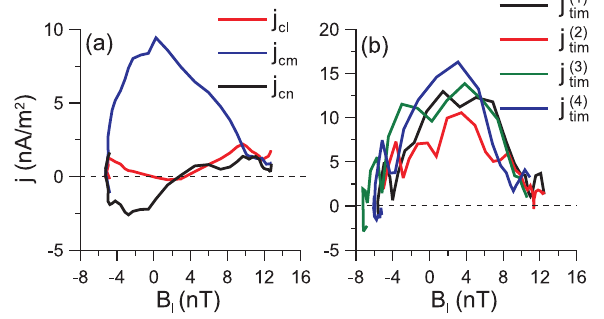
Fig. 3. CS 29: (a) components j cl , j cm , j cn of the curlometer cur- rent j c and particle currents j pm and j em across the CS; (b) timing currents j (α) across the tim